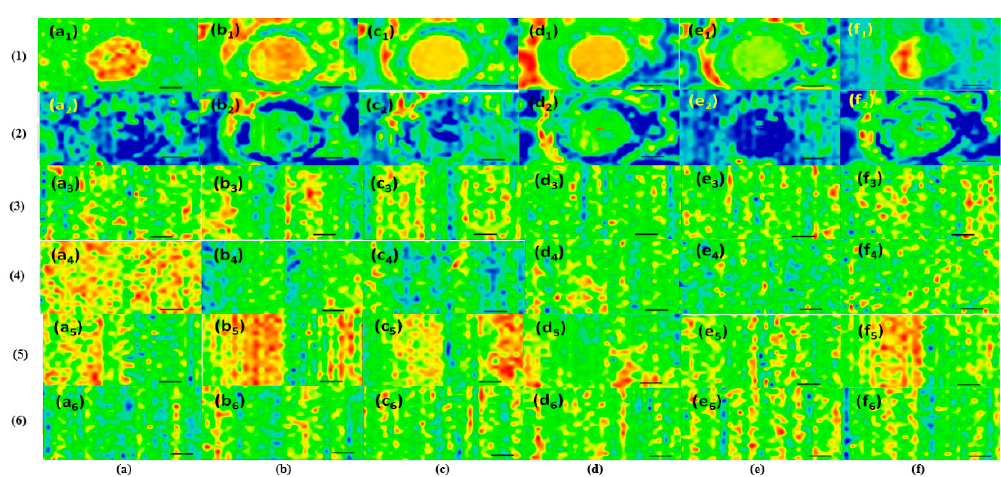
Figure 1. Infrared spectroscopy (IR) mapping data. Intensity distribution of dropcast surfaces: ( 1 )